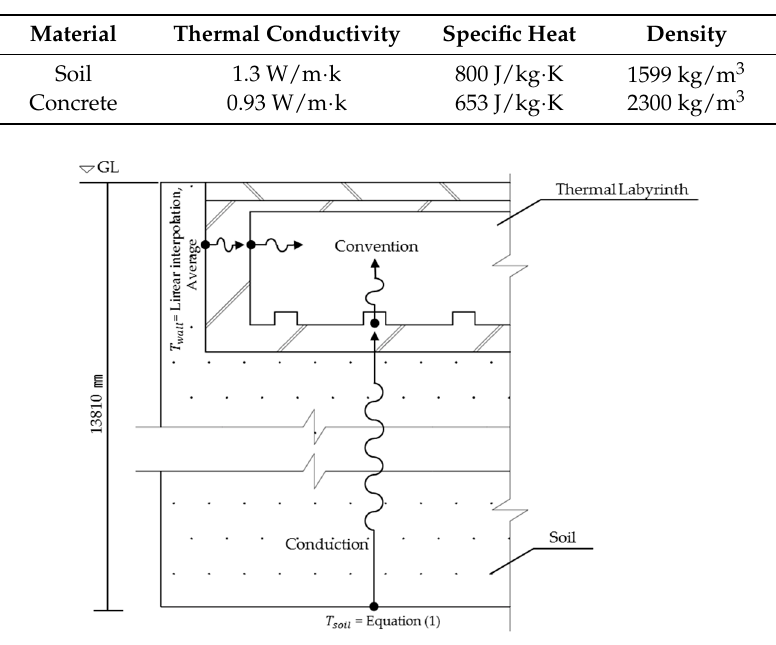
Table 4. Properties of the material applied to the simulation.